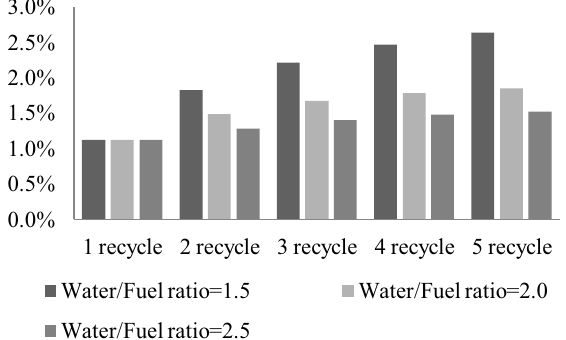
Fig. 3. The plutonium fraction in the fresh REMIX-fuel (for each